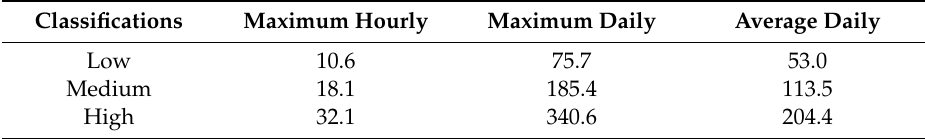
Table 4. Hot water demand and guidelines (adapted from ASPE 2003).